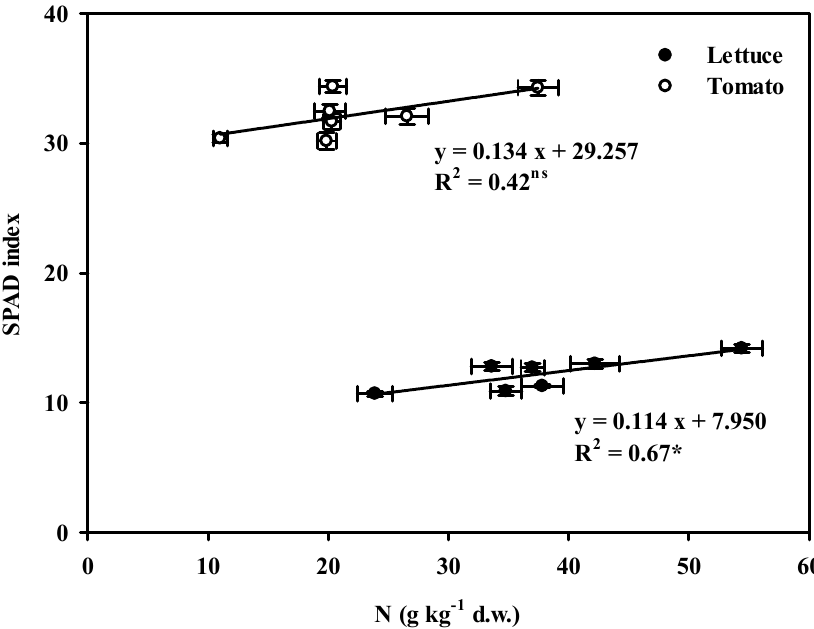
Figure 1. Relationship between the Soil-Plant Analysis Development (SPAD) index and nitrogen (N) content of leaves in tomato and lettuce. Bars represent standard errors of the means (Experiments 1 and 2).